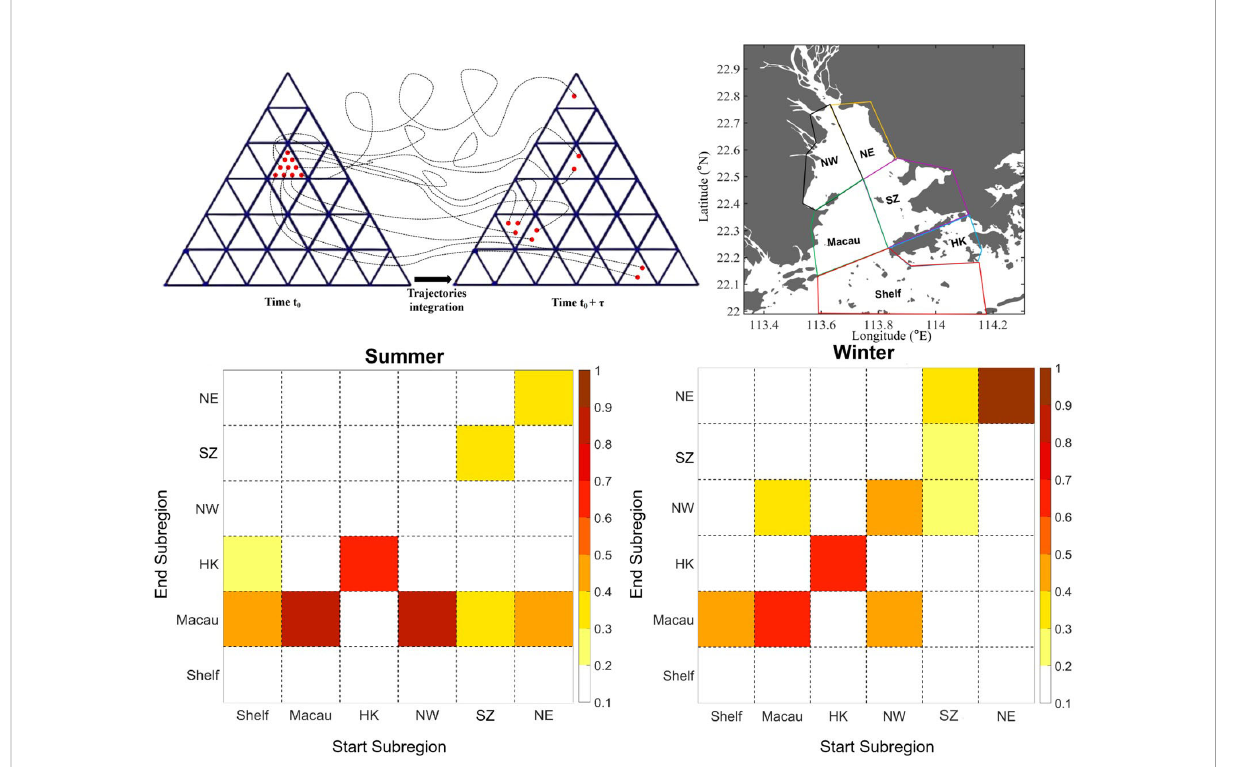
FIGURE 8 (A) Schematic fi gure showing the starting and ending subregions to conduct the connectivity matrix. (B) The six subregions in the PRE. (C, D) show the connectivity among six subregions in summer and winter,